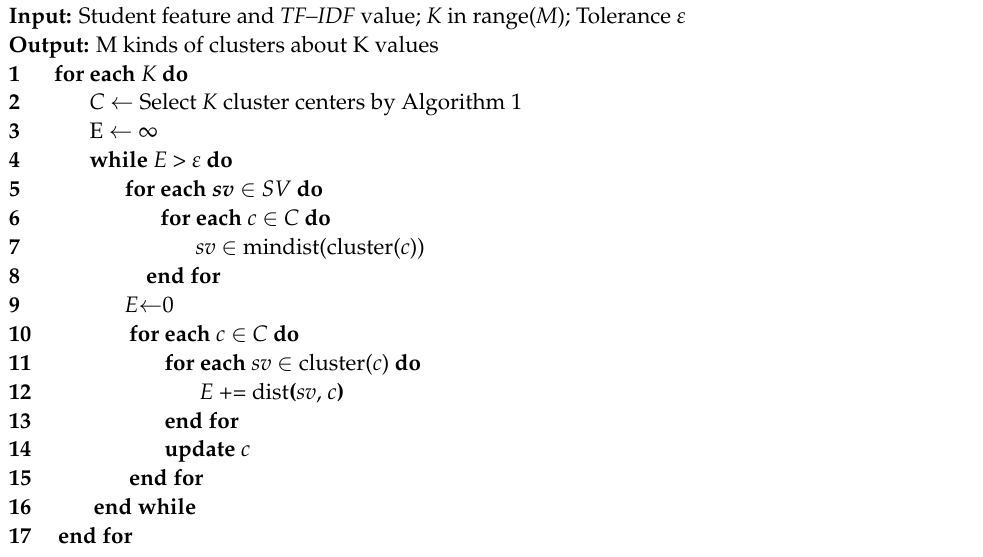
Algorithm 2 Student grouping method based on an improved K-means